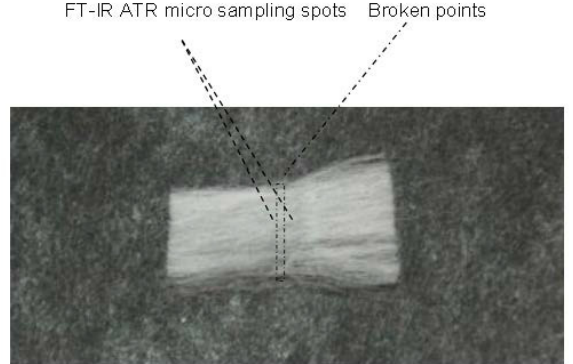
Figure 7. Scheme of broken points to flat bundle fibers from Stelometer strength measurement and ATR-FTIR micro sampling spots (Reprinted with permission from [19]. Copyright 2012 American Society of Agricultural & Biological